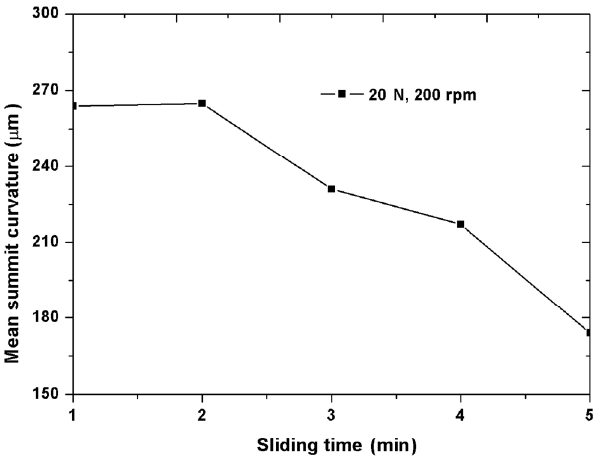
Fig. 11 Variation of mean summit curvature ( S sc ) with sliding time.